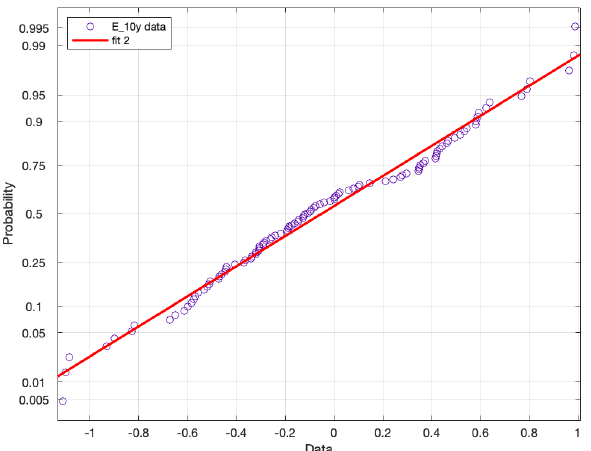
Figure 9. Q-Q plot of the empirical distribution of the standardized residuals for the 5-year bond yield.